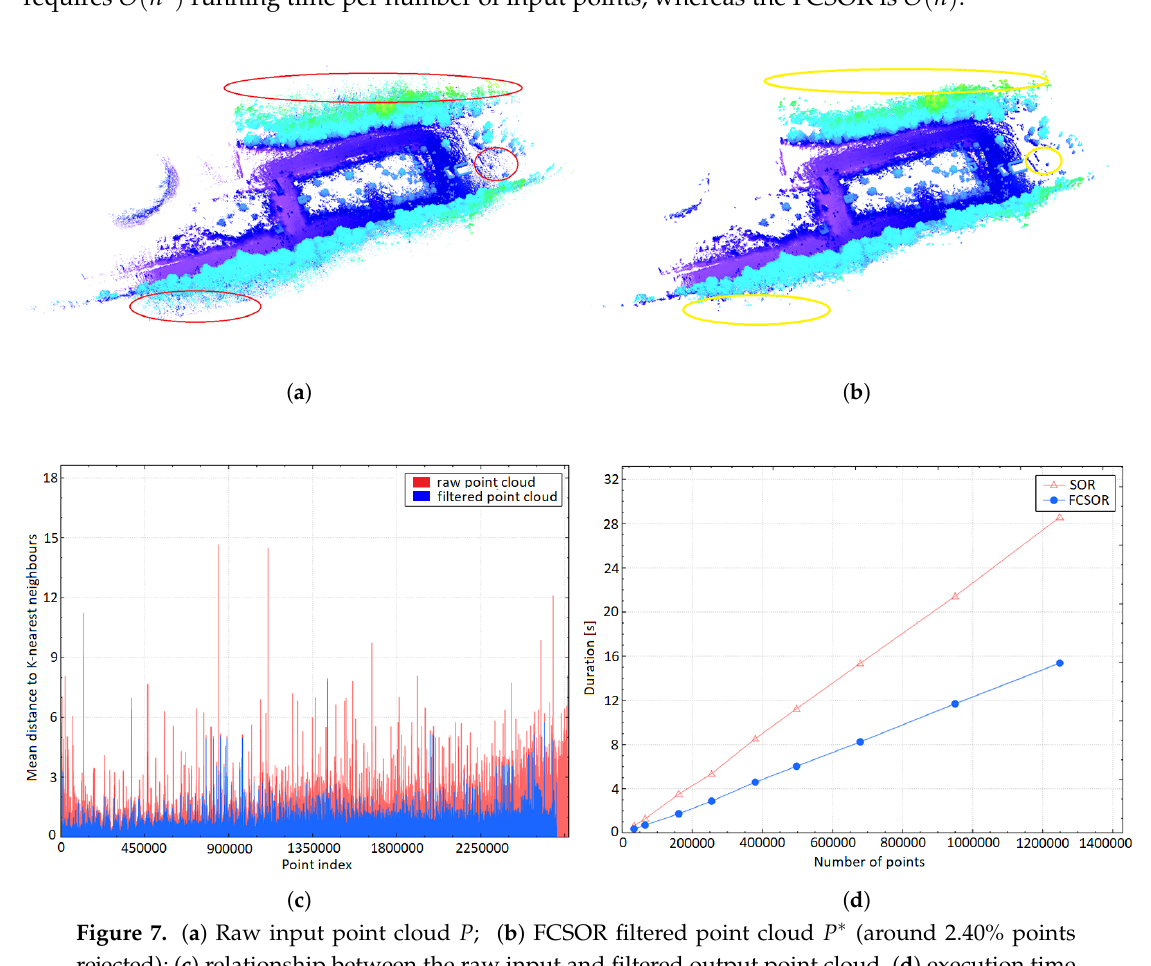
Figure 7. ( a ) Raw input point cloud P ; ( b ) FCSOR filtered point cloud P ∗ (around 2.40% points rejected); ( c ) relationship between the raw input and filtered output point cloud, ( d ) execution time comparison between FCSOR and SOR methods for different density 3D input (Dataset: Military-base Marche-en-Famenne,